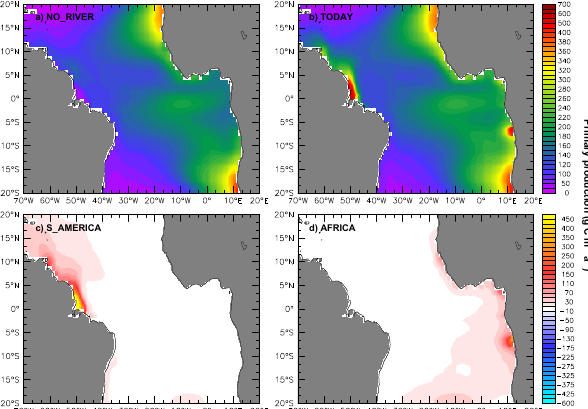
Fig. 7. Mean fields of integrated primary production (PP) in gCm − 2 a − 1 (average 1998–2005) (a) NO_RIVER scenario, (b) the TODAY scenario, (c) difference between the S_AMERICA and NO_RIVER scenarios, and (d) difference between the AFRICA and NO_RIVER scenarios.